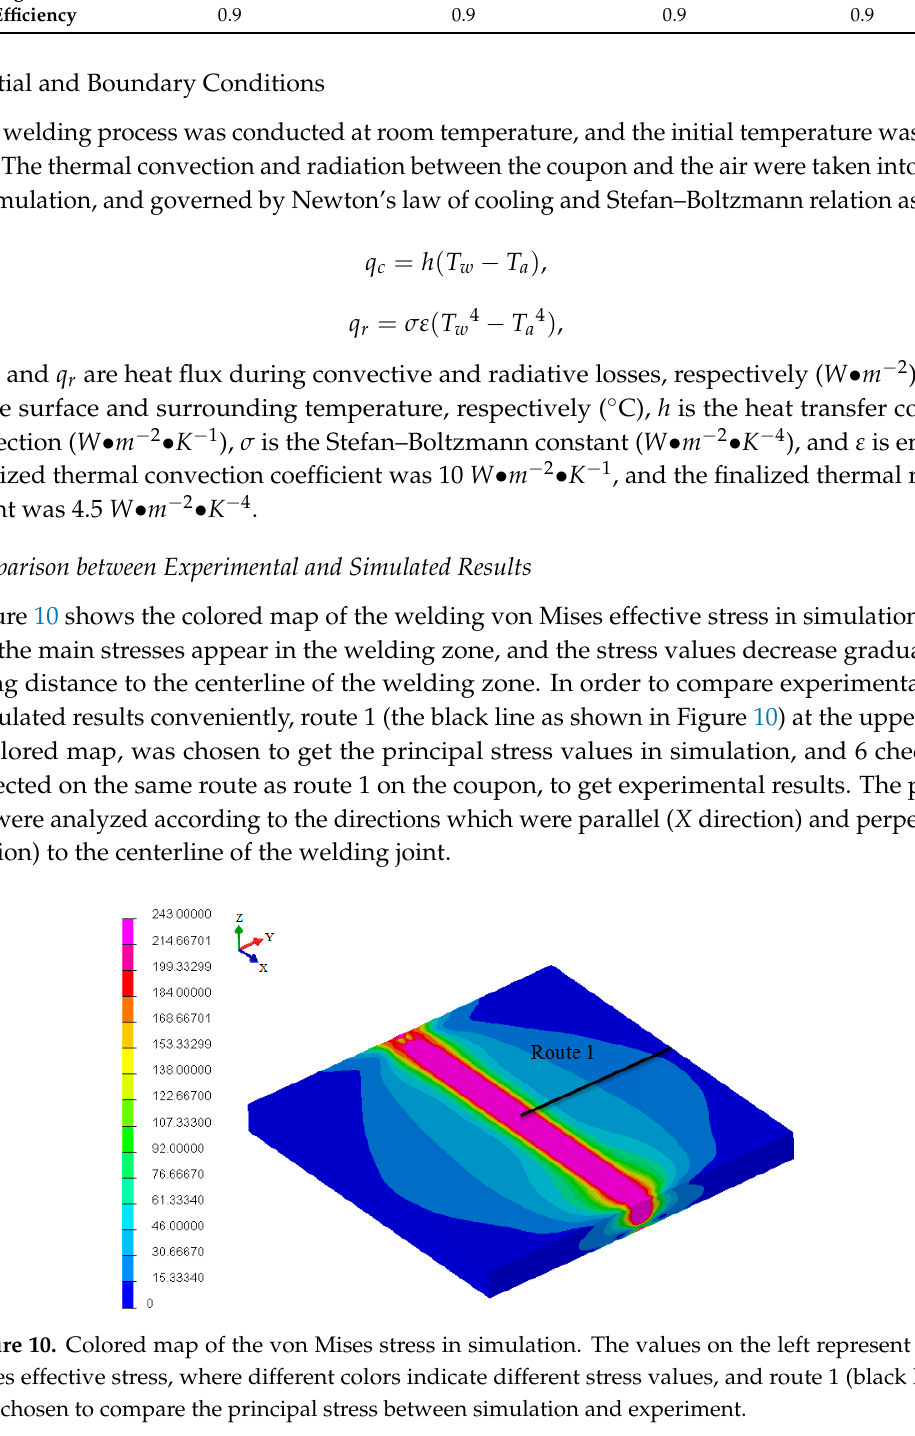
Figure 11. Comparison of the principal stresses between simulation and experiment. ( a ) The stresses in the Y direction (perpendicular to the welding direction); ( b ) the stresses in the X direction (parallel to the welding direction). 0